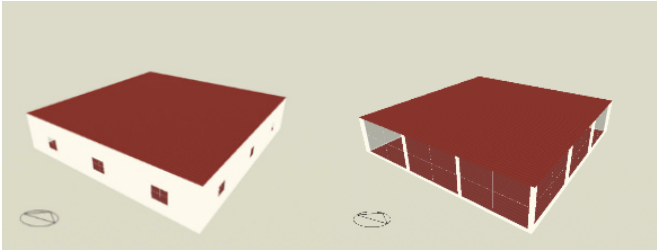
Figure 3. Window to wall ratio examples. WWR = 10 on the (left) and WWR = 100 on the (right).